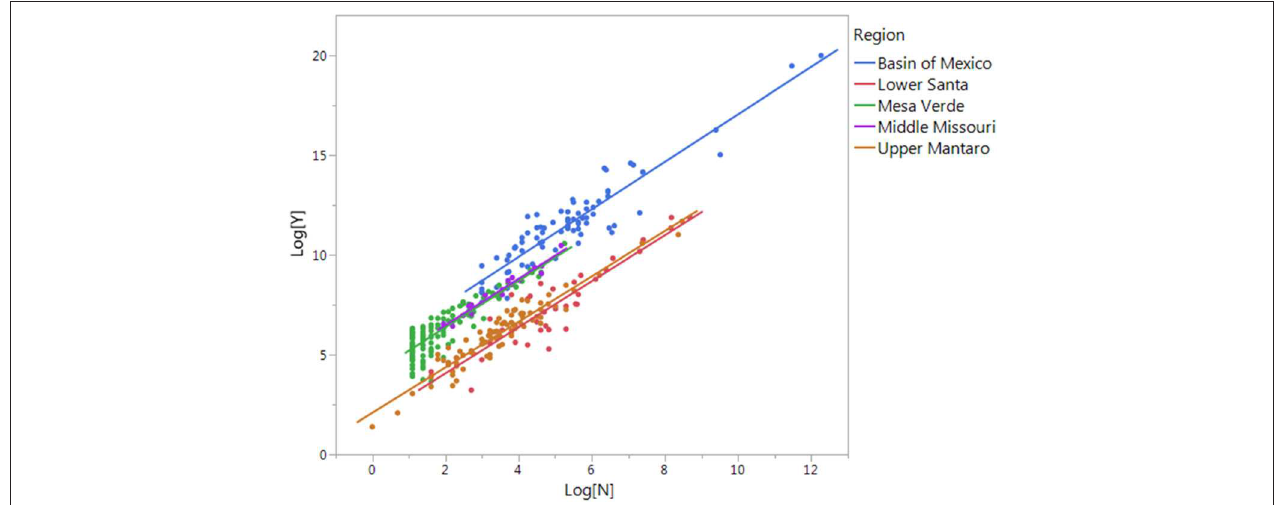
FIGURE 1 | The relationship between settlement population and total house area in five New World societies. Note that the intercept of the fit line for each society is different, but the slope (coefficient) of the fit line is very similar across cases.